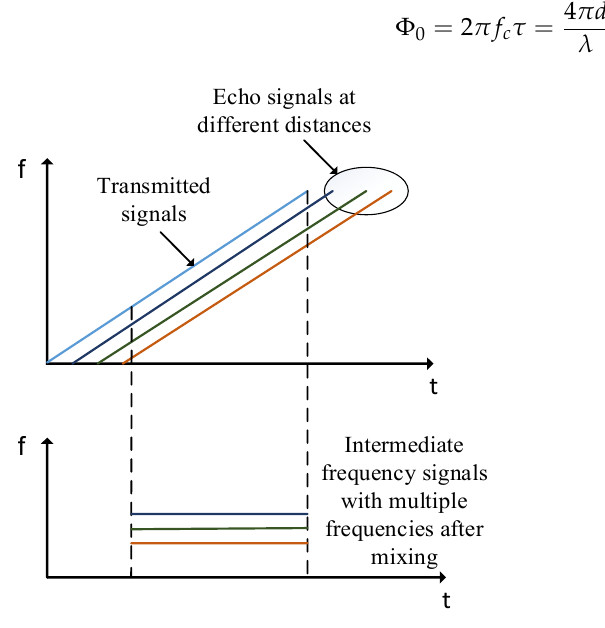
Figure 2. IF signal generation